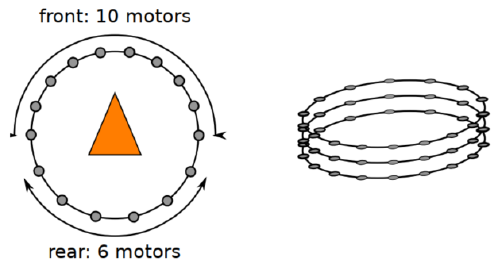
Figure 10. Vibrator distribution on the belt (the triangle provides the orientation of the user’s